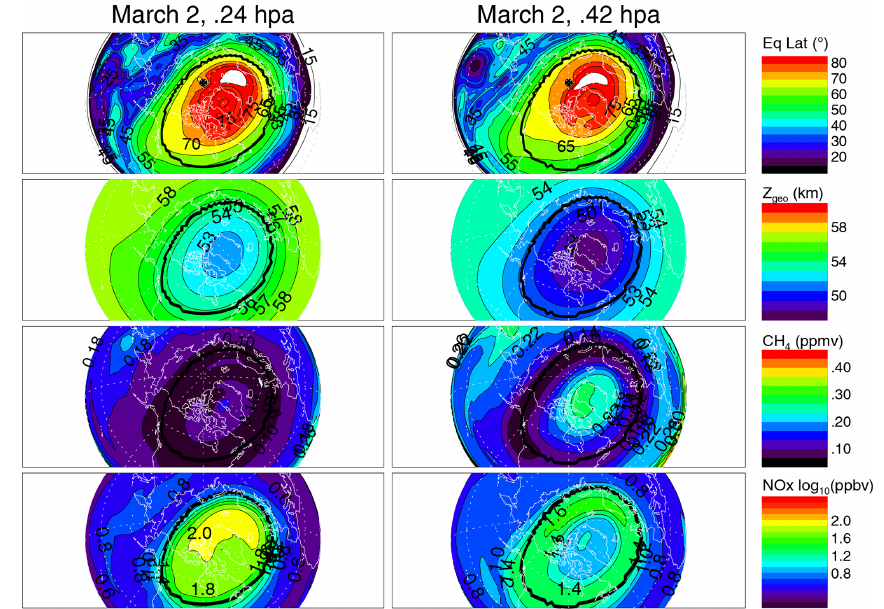
Figure 11. Polar plots of equivalent latitude (top row), geopotential height ( Z , second row), CH 4 (third row), and NO x (bottom) from WACCMX. The contour interval is 5 ◦ of latitude for equivalent latitude, 1km for Z , and 0 . 2log 10 (ppbv) for NO x . The orientations of the maps are such that the center of each map is 80 ◦ N, 90 ◦ W. Table 1. Estimates of MLT NO x deposition in WACCMX and observations (in gigamoles). Dates Vortex Equiv lat Equiv lat Equiv lat High CH 4 Low CH 4 Geom. only 55–75 60–75 60–80 threshold a threshold b est. c 1–3 March 0.18 0.15 0.12 0.15 0.27 0.24 0.10 23–25 March 0.11 0.17 0.12 0.15 0.27 0.18